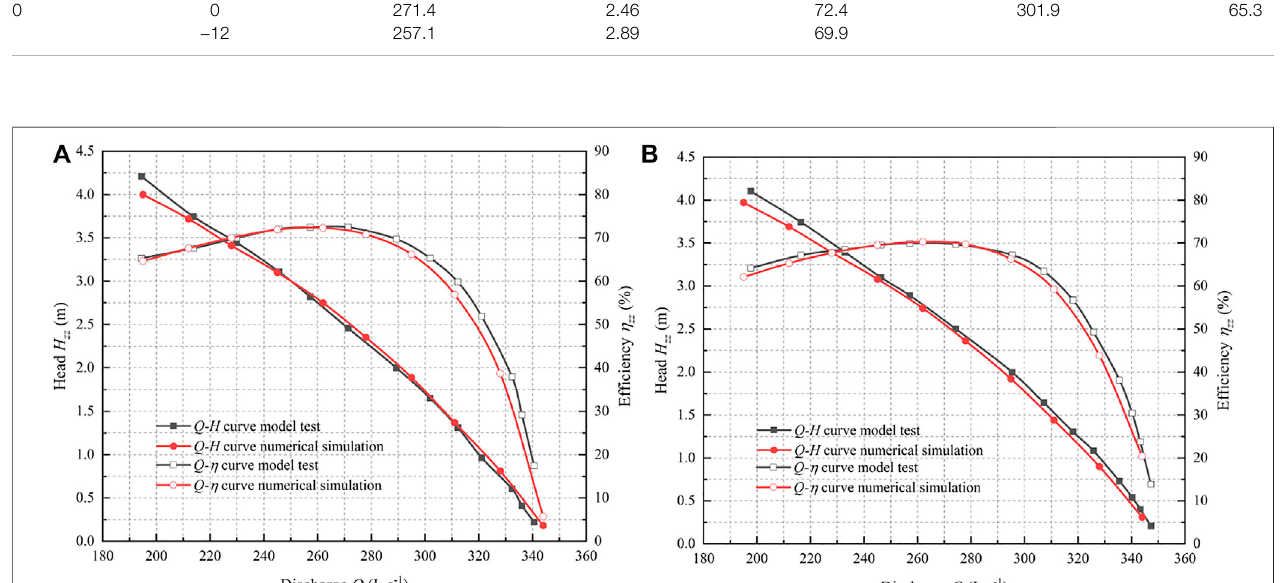
FIGURE 16 | Comparison of model test and numerical calculation results of energy performance of the pump device with α of 0 ° . (A) Δβ = 0 ° , (B) Δβ = − 12 ° .